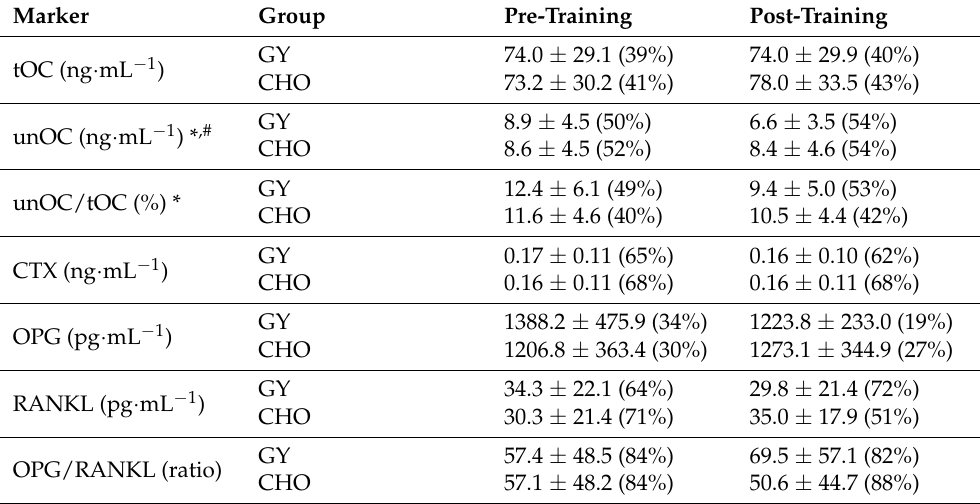
Values are mean ± standard deviation (% coefficient of variation); t-OC = total osteocalcin (N = 13); unOC = undercarboxylated osteocalcin (N = 10); unOC/tOC = relative undercarboxylated osteocalcin to total osteocalcin (N = 10); CTX = C-terminal telopeptide of type I collagen (N = 10); OPG = osteoprotegerin (N = 13); RANKL = receptor activator nuclear factor kappa- β ligand (N = 10); OPG/RANKL ratio (N = 10); * denotes significant main effect for time; # denotes significant time by condition